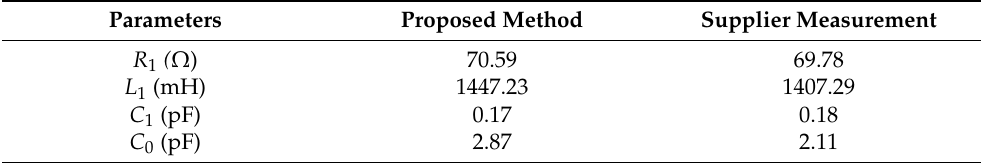
Figure 5. Measured curve and inversion curve of standard resonator: ( a ) phase–frequency curve; ( b ) magnitude–frequency curve. Table 1. Comparison between the parameters measured by the proposed method and those provided by the supplier.